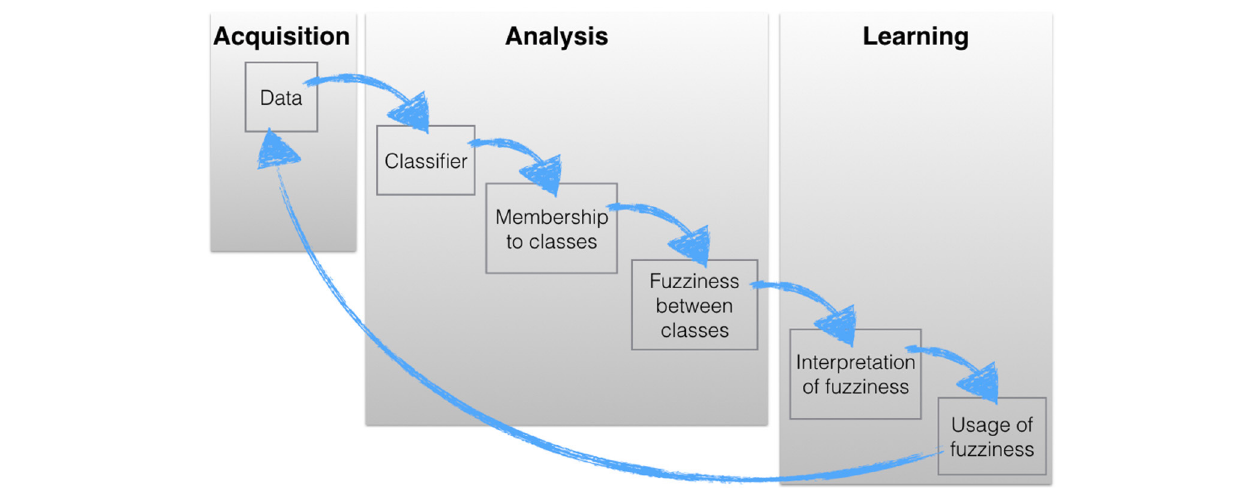
FIGURE 1 | Example of learning classifier workflow using a fuzzy clustering. The learning phase is linked to the data acquisition because fuzziness may highlight data weakness, thereby areas where new data acquisition is required. Note that the same workflow can be translated to any other methods that allow uncertainty.